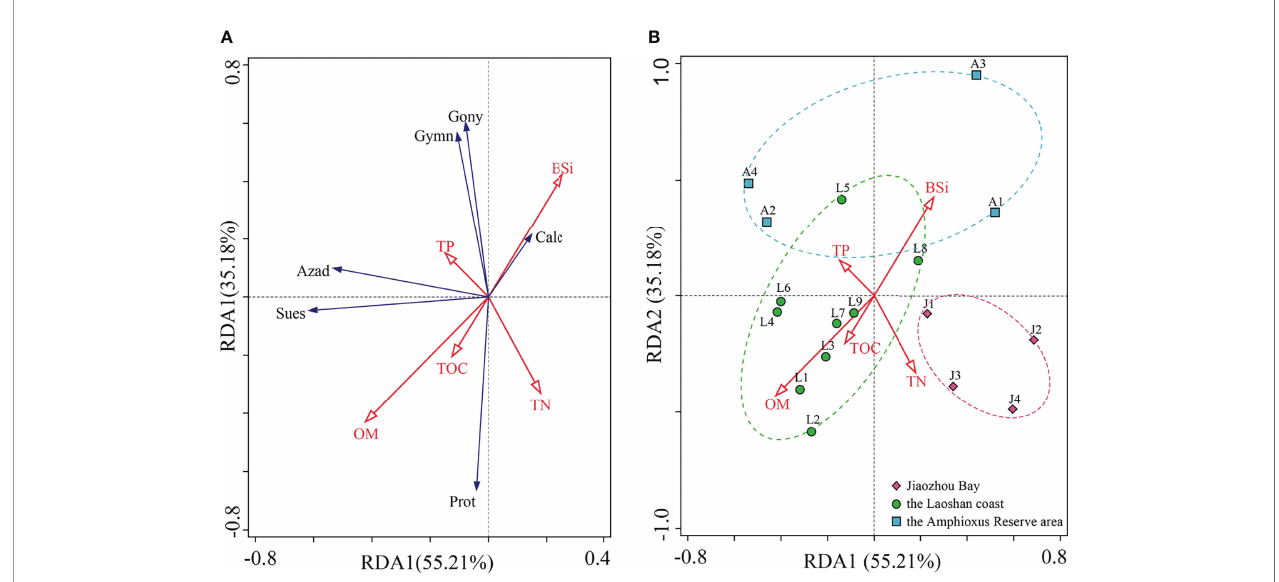
FIGURE 8 | Redundancy analysis (RDA) of biogenic elements and dinocysts in surface sediments from the Qingdao coast, showing cyst distribution and the directions of biogenic elements to the fi rst two RDA axes, RDA1 (55.21%) and RDA2 (35.18%). The length of arrows indicates the importance of biogenic elements in explaining the distribution of cysts. The direction of the arrows shows approximate correlation to the ordination axes. (A) Ordination dinocyst groups and (B) ordination sampling stations, showing the distribution of the three areas.